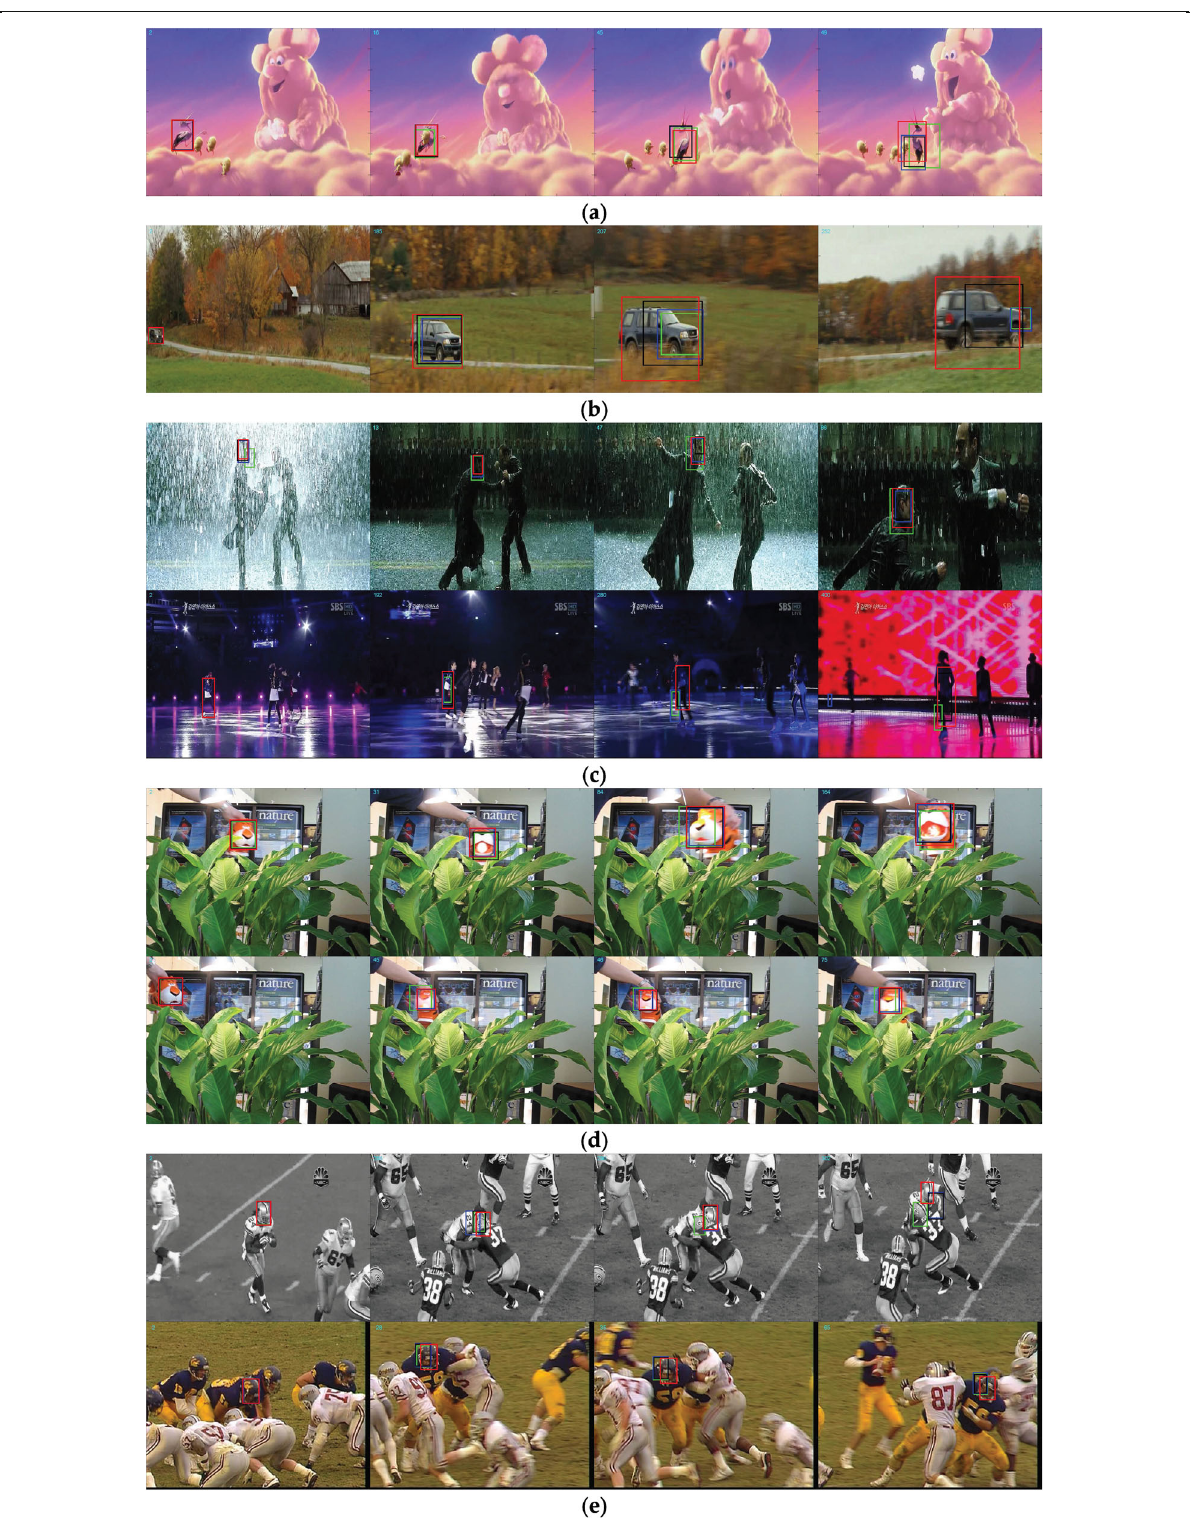
Fig. 7 Qualitative comparison. a bird2; b carscale; c matrix, skating1; d tiger1, tiger2; e football, football1. The tracking result of BPCF, ECO, C-COT, and CFWCR are marked in red, black, blue, and